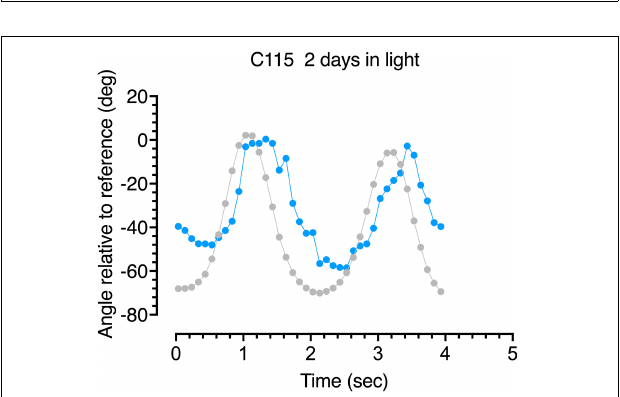
FIGURE 7 | Gaze following responses (blue symbols) to a swinging large pendulum (gray symbols) for a 6-week dark-reared kitten (C115) made on the third day of exposure to light.